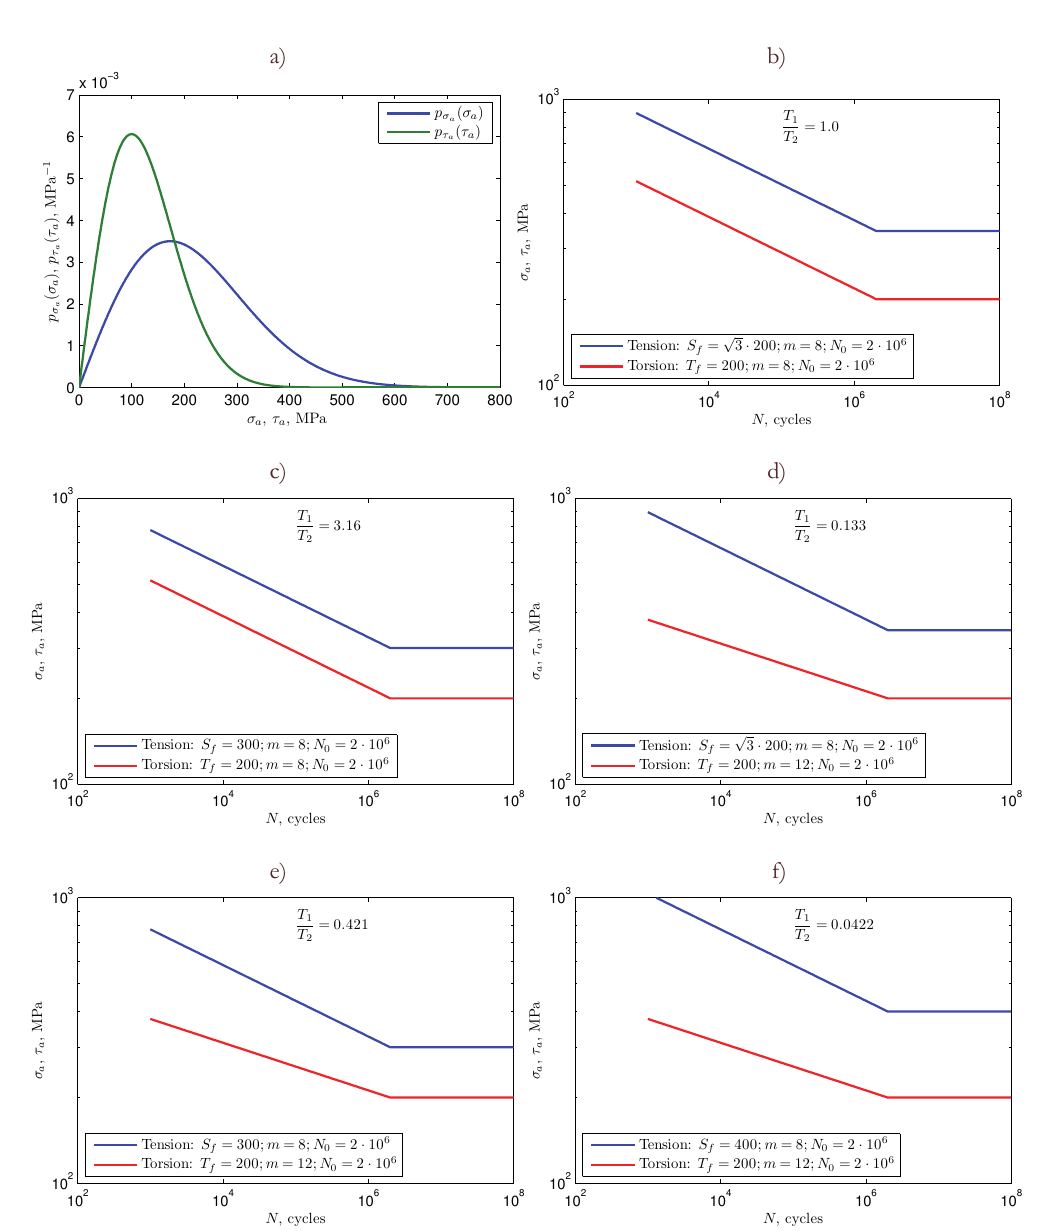
Figure 1: PDF of amplitudes used for computation of fatigue life T1 and T2 (a) and five sets of SN curves for torsion and uniaxial tension (b), (c), (d), (e), and